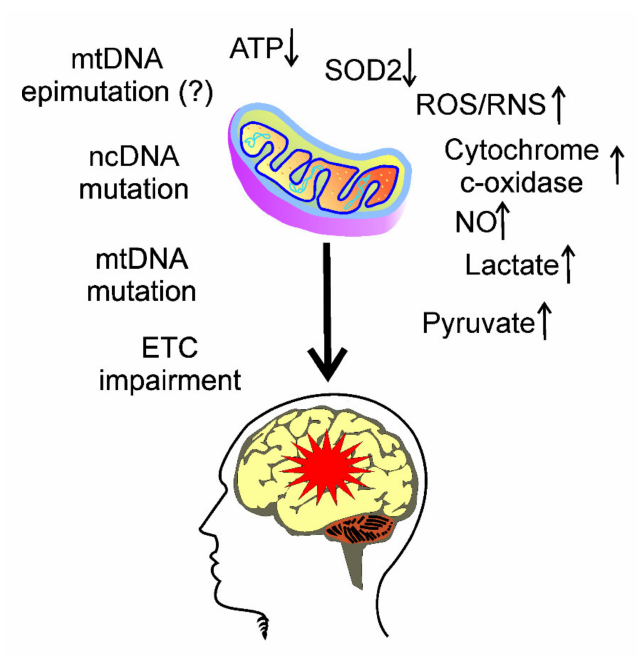
Figure 2. Migraine associates with mitochondrial dysfunction and energy production. Impairment of the electron transport chain (ETC) in mitochondria may result in decreased ATP production. There are several reasons and consequences of this impairment, including mutations and epimutations in both mitochondrial DNA (mtDNA) and nuclear DNA (ncDNA), decrease in the activity of mi- tochondrial superoxide dismutase (SOD2), which, along with impaired ETC, may contribute to increased production of reactive oxygen and nitrogen species (ROS and RNS, respectively), activation of cytochrome-c oxidase and nitric oxide, high levels of lactate and pyruvate, as well as other effects, which together may be involved in migraine headache (red star)